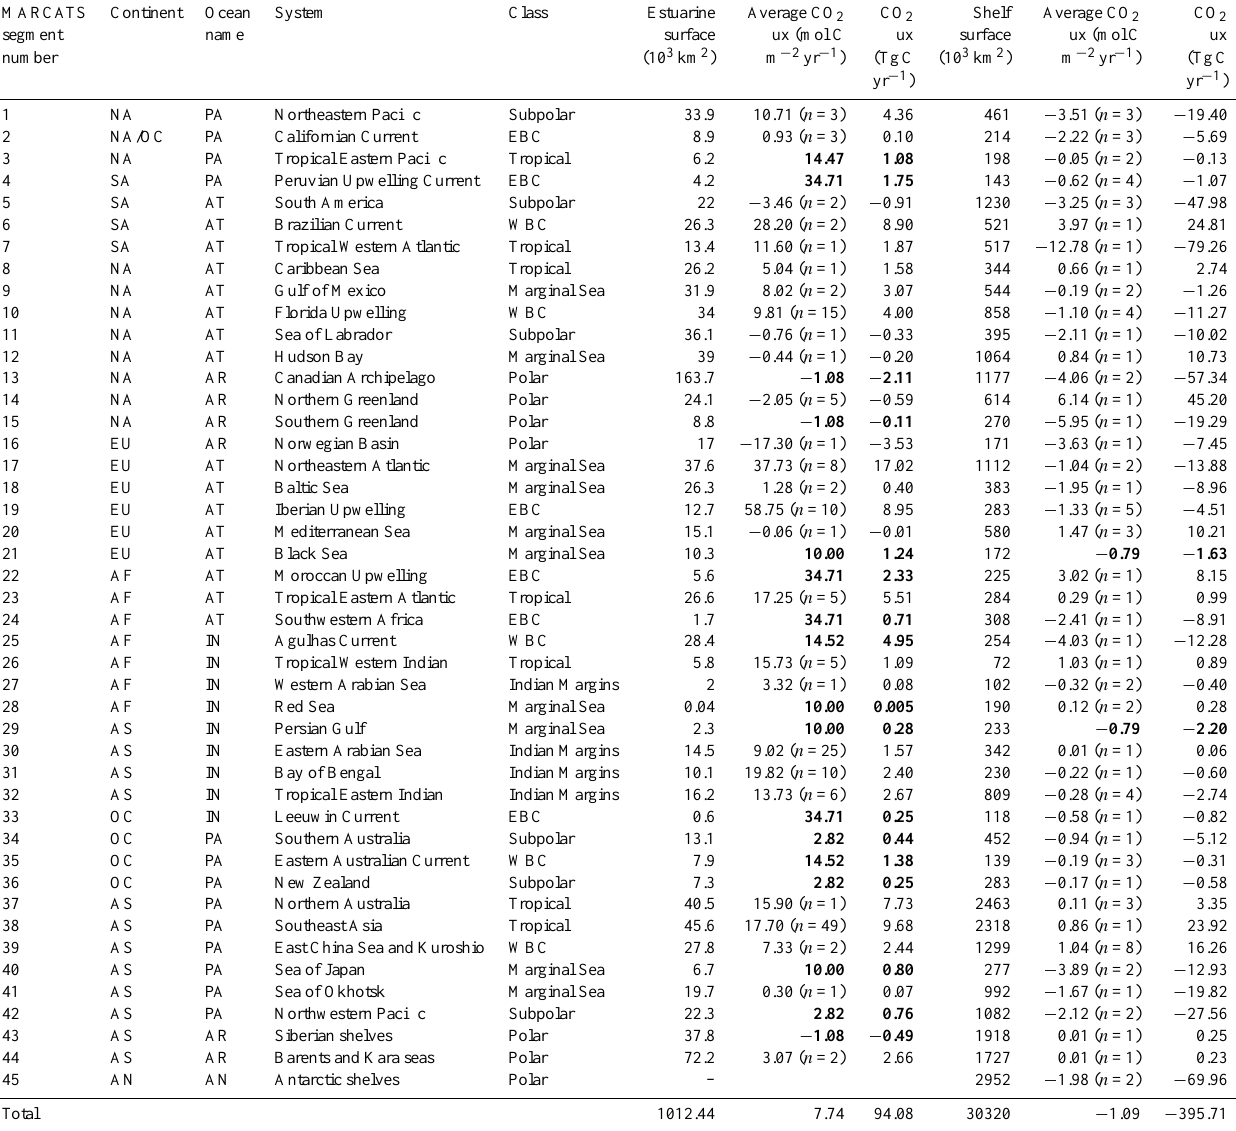
Table 3. Areas and air–sea fluxes of CO 2 in estuaries and continental shelves by biogeochemical provinces (Laruelle et al., 2013). MARCATS Continent Ocean